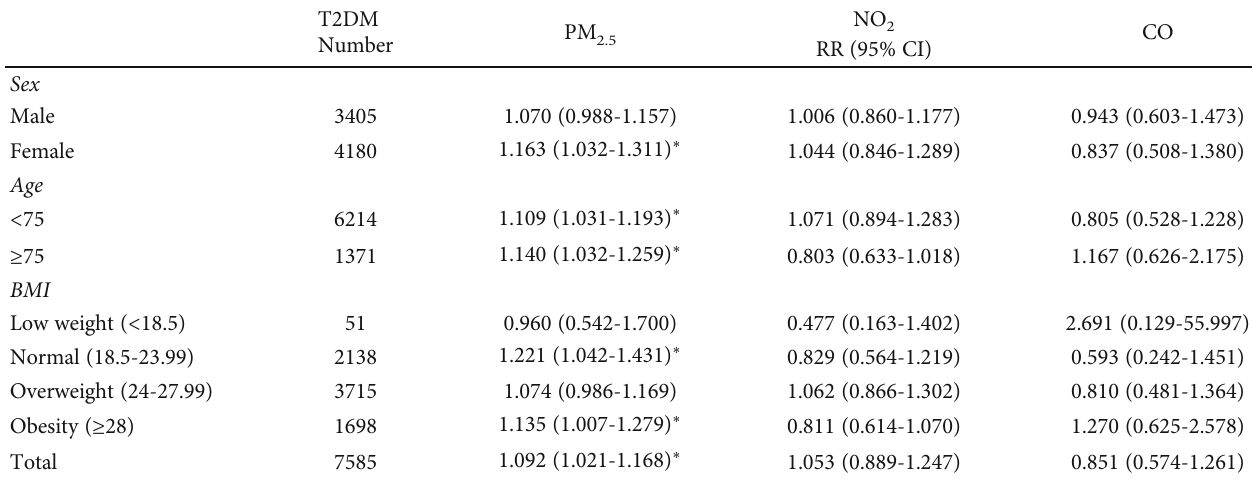
Table 6: Results of subgroup analysis based on sex, age, and